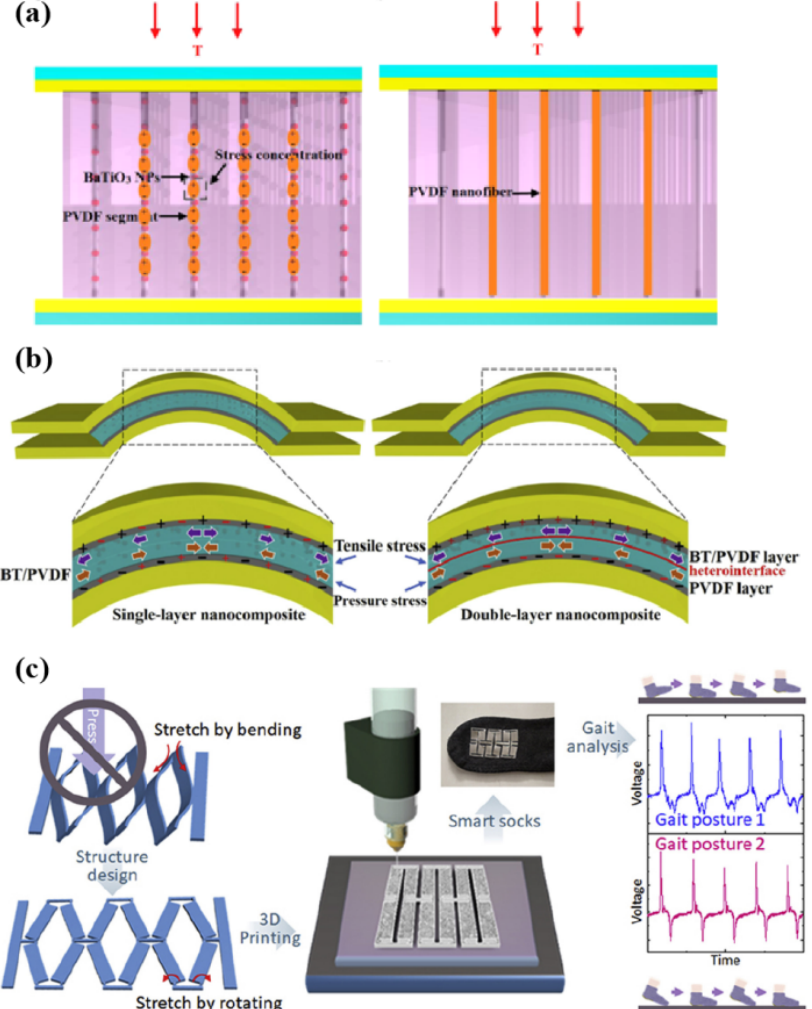
Figure 6. ( a ) Schematic of a vertical stress applied to composite nanogenerator (NG) and pure PVDF PENG [49]. ( b ) Schematic of distributions of stress and related induced charges in the single–layer and double–layer BaTiO 3 (BT)/PVDF nanocomposite films [50]. ( c ) Schematics, image, and gait analysis of the fully printed PENG installed on socks [51]. Reproduced with the permission from references [49–51].